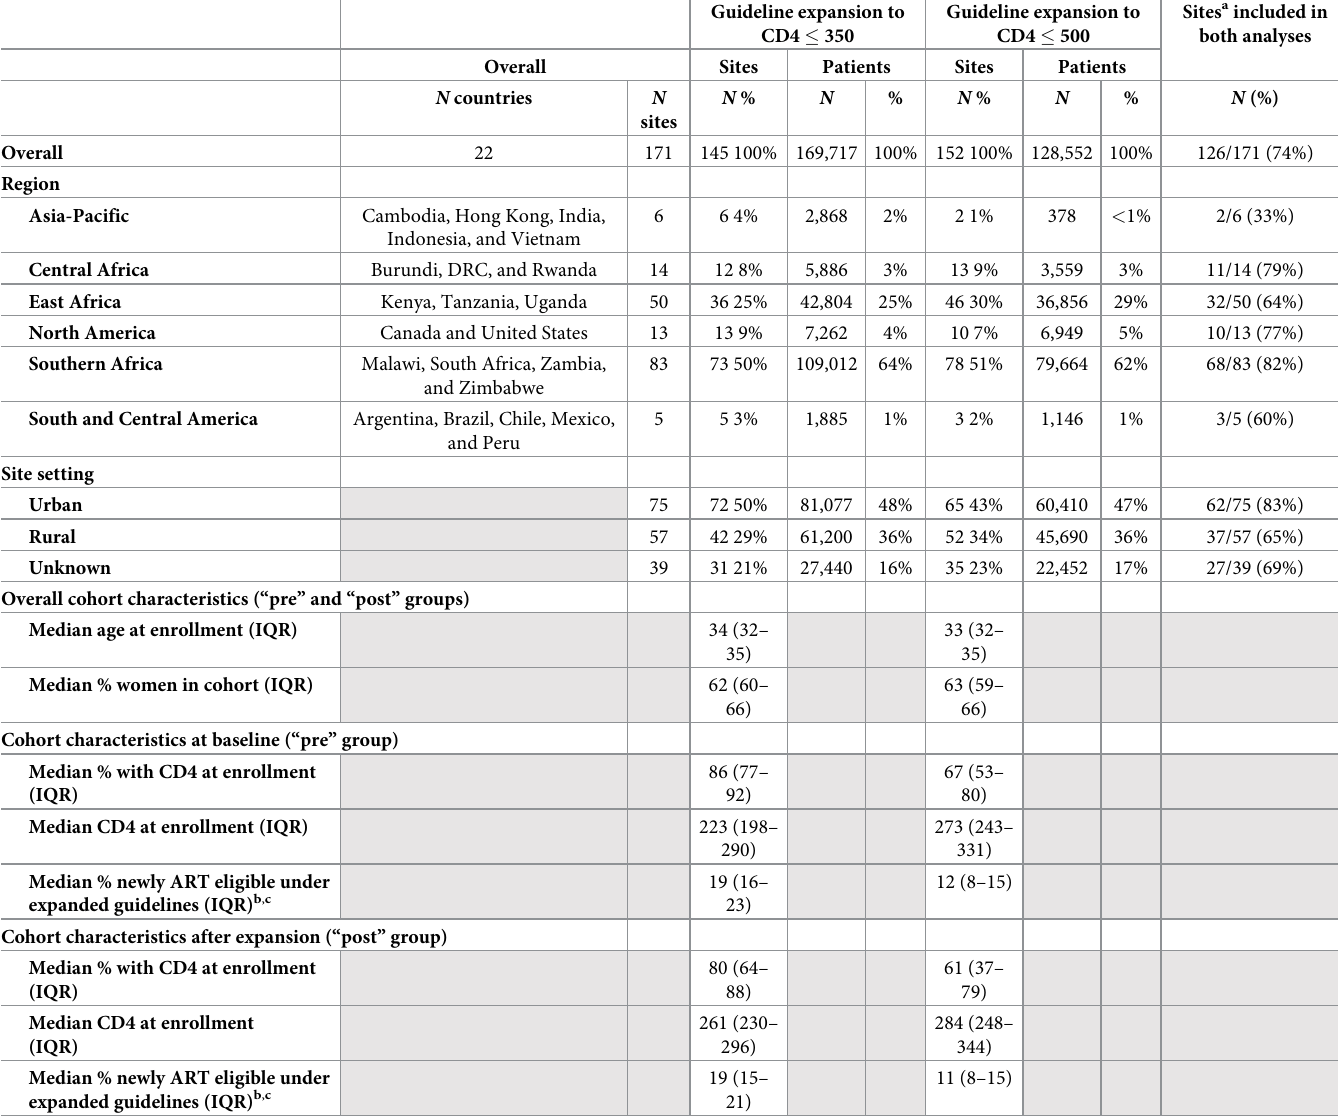
Table 1. Characteristics of 171 sites and 284,740 patients included in the